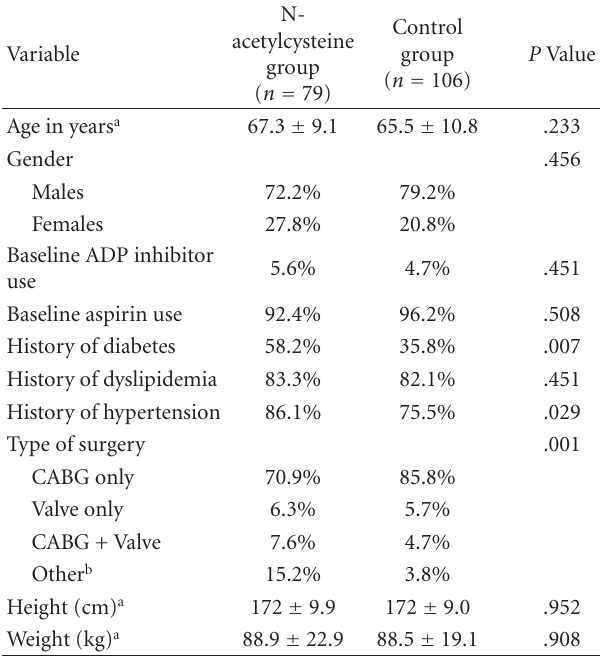
Table 1: Patient demographics.